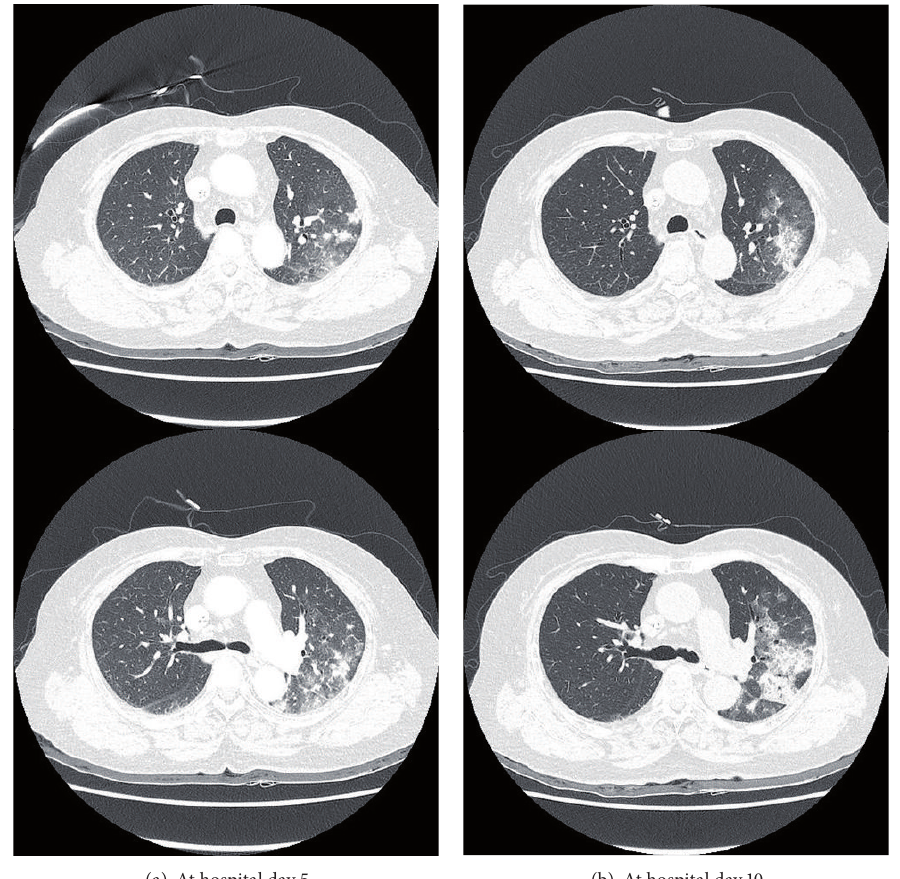
Figure 3: Chest CT findings of lung